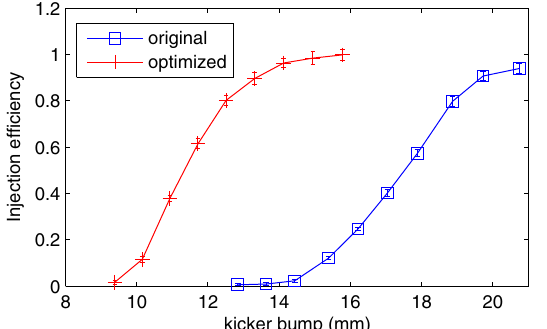
FIG. 5. Lifetime vs rf gap voltage for the original and optimized solutions. Initial current was 100 mA in 80 bunches for both cases, which was Touschek lifetime